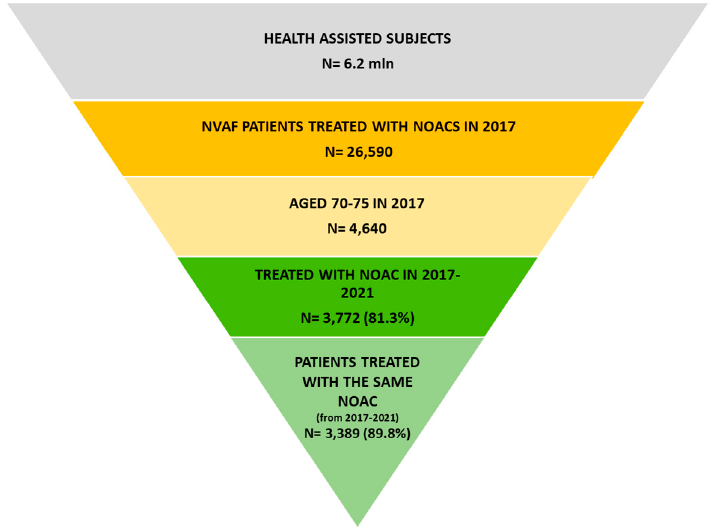
Figure 2. Flow chart of patients’ identification. Among 6.2 million health-assisted individuals, 26,590 patients with a diagnosis of NVAF and treated with NOAC during 2017 were identified. Among them, those aged 70–75 were selected (N = 4640). In total, 3772 patients prescribed with NOAC across 2017 and 2021 were identified, and among them 3389 patients, who in 2021 remained with the same NOAC started during 2017, were included. Table 1. Evaluation of comorbidities occurrence in patients remaining with the same NOAC across 2017 and 2021 (N =